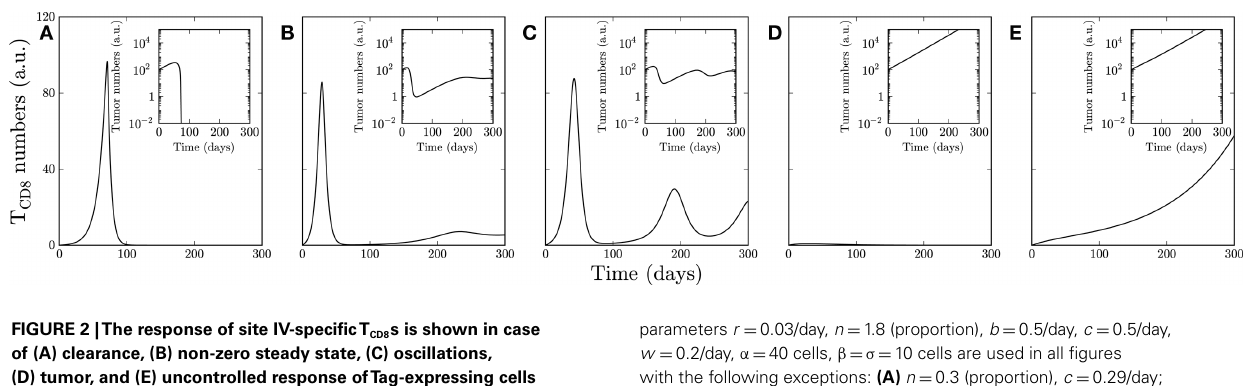
FIGURE 2 |The response of site IV-specificT CD8 s is shown in case of (A) clearance, (B) non-zero steady state, (C) oscillations, (D) tumor, and (E) uncontrolled response ofTag-expressing cells (Tag-expressing cells shown in insets). In all cases the initial condition isTag-expressing cells = 100, site IV-specificT CD8 = 0.The